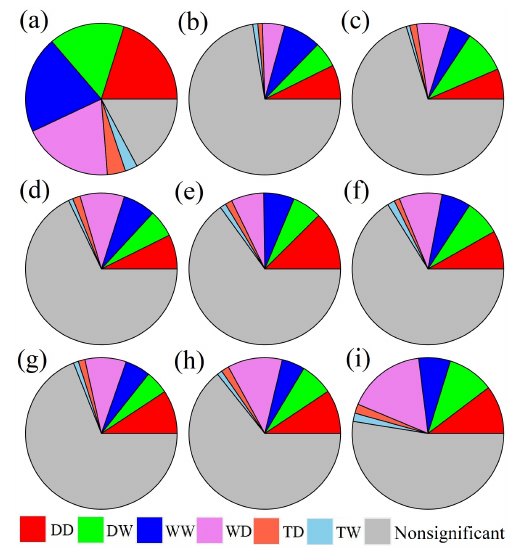
Figure 5. Fraction of the global land area (in percentage) with different patterns during the (a–f) historical (1985–2014) and (g– i) future (2071–2100) periods under (g) SSP126, (h) SSP245, and (i) SSP585 scenarios based on TWS-DSI. Note that the historical results are based on the (a) GRACE reconstruction, (b) WGHM, (c) VIC, (d) CLSM, (e) Noah, and (f) ensemble mean of eight GCMs, respectively. The future results are based on the ensemble of eight GCMs. DD indicates the dry gets drier, DW indicates the dry gets wetter, WW indicates the wet gets wetter, WD indicates the wet gets drier, TD indicates the transition gets drier, and TW indi- cates the transition gets wetter. Nonsignificant indicates the regions showing nonsignificant ( p> 0 . 05) trends in